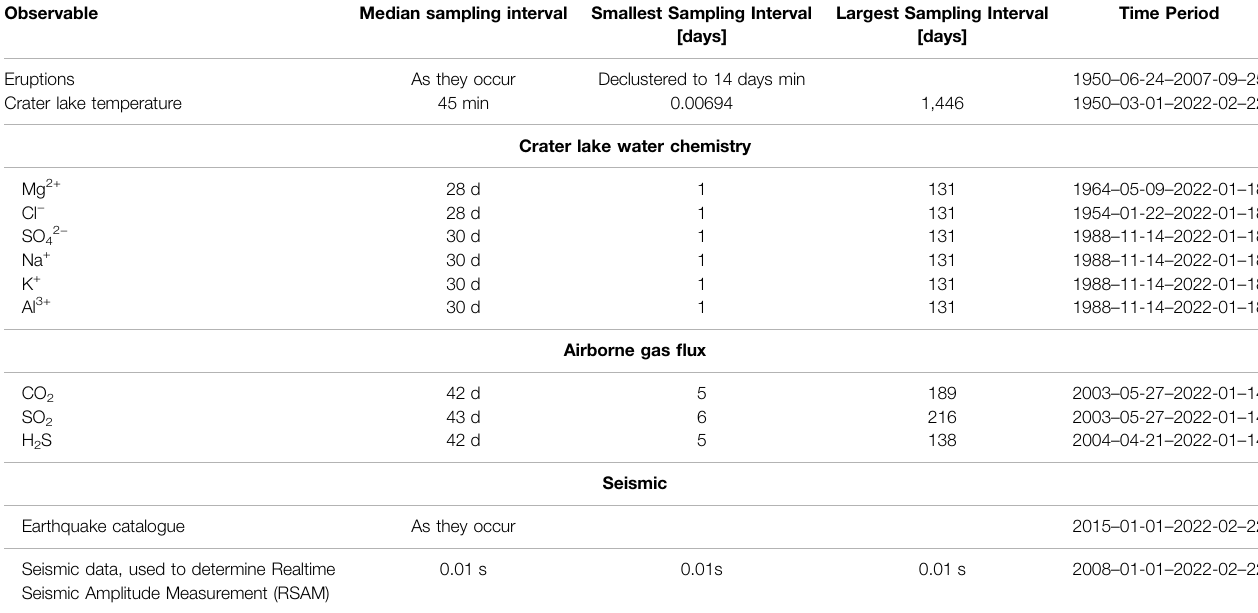
TABLE 1 | The available monitoring data, their median, smallest and largest sampling intervals, and time period of recording.